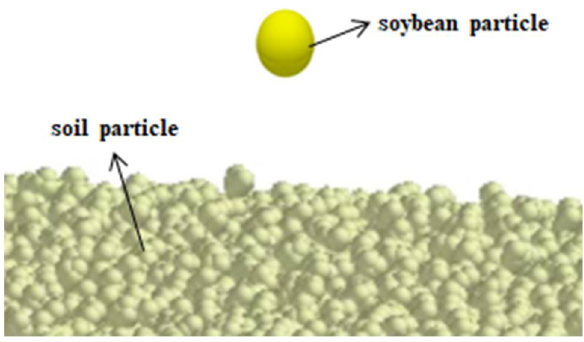
Figure 8. Screenshot of seed throwing test simulation.